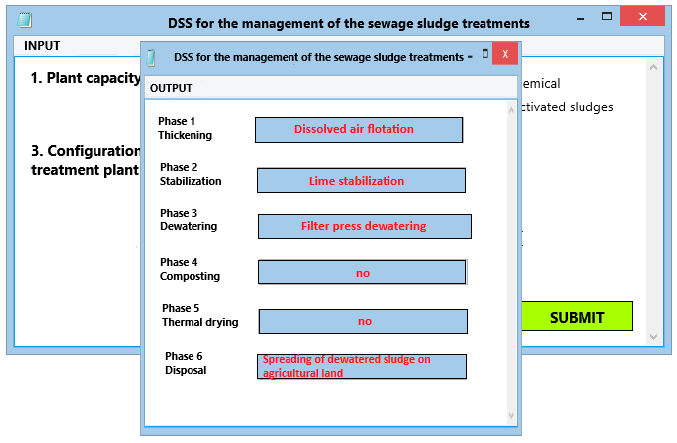
Figure 8. Screenshot of the VBA output query interfaced with the ANN model.